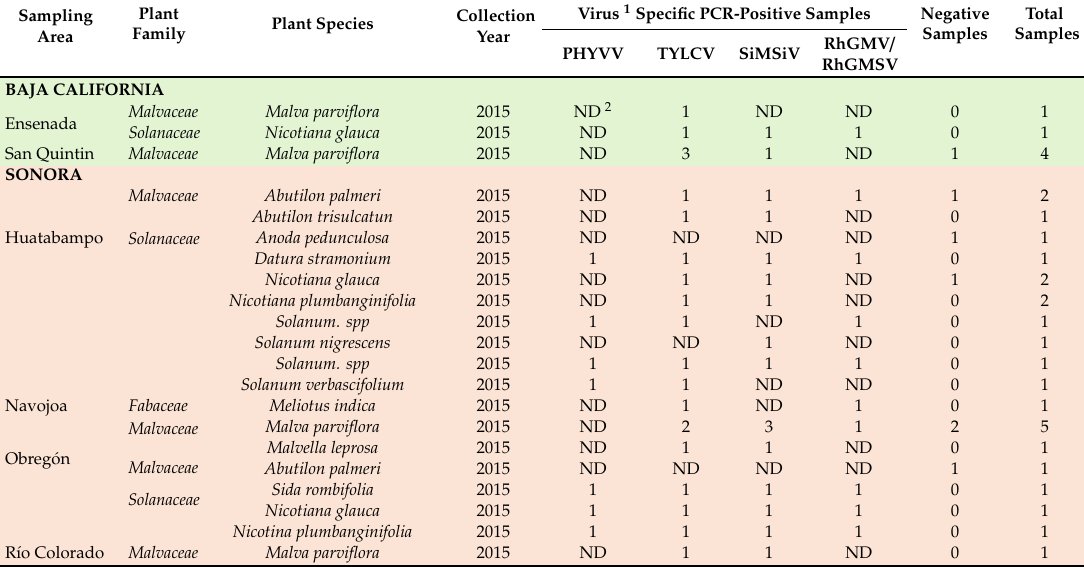
Table 6. Specific PCR detection of begomovirus in individual non-cultivated plants collected from di ff erent counties of the five Northern Pacific-regions of Mexico included in this